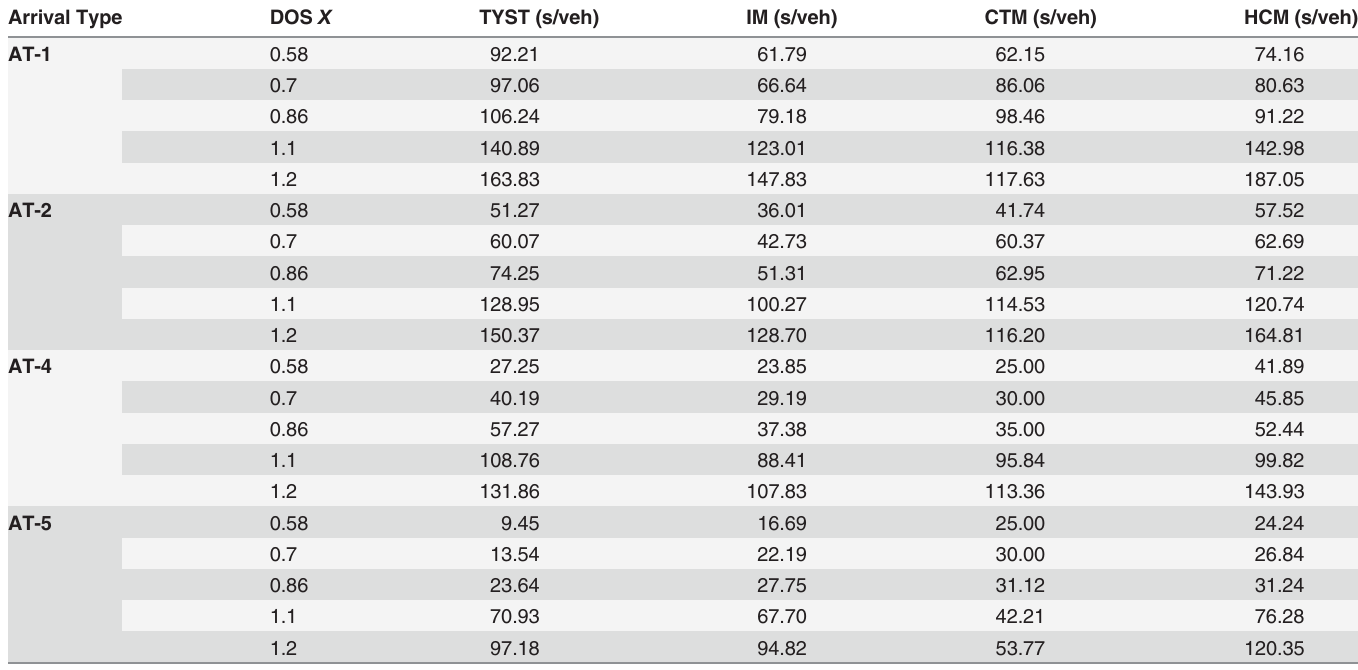
Table 6. Comparison of Average Delays (T = 15 min). Arrival